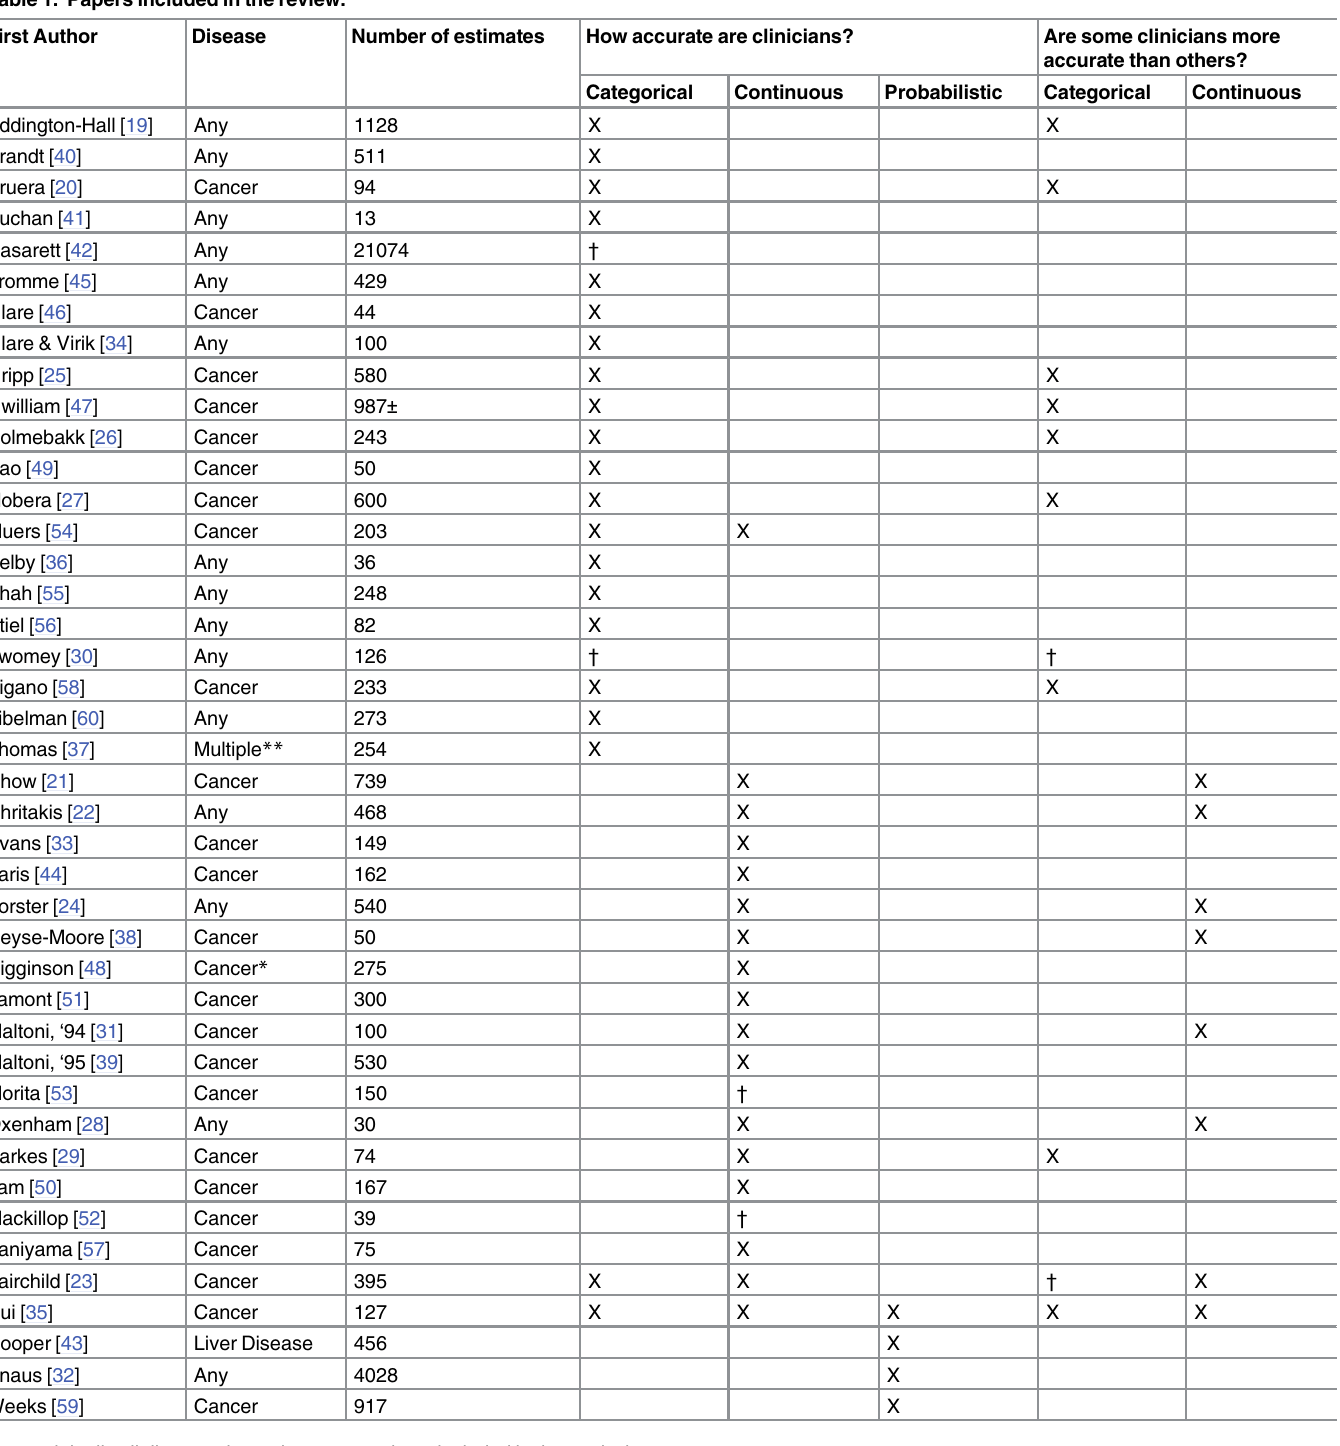
Table 1. Papers included in the